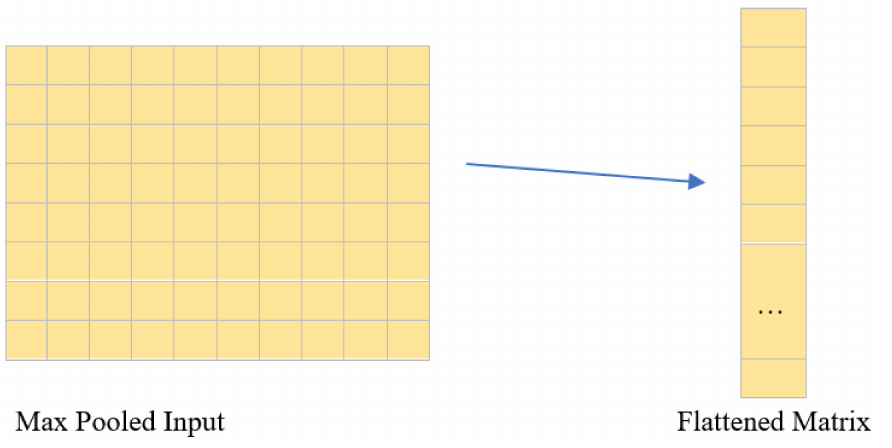
Figure 6. Graphic demonstrating the role of the Flatten layer in converting a 2D grid to a 1D vector. Dense